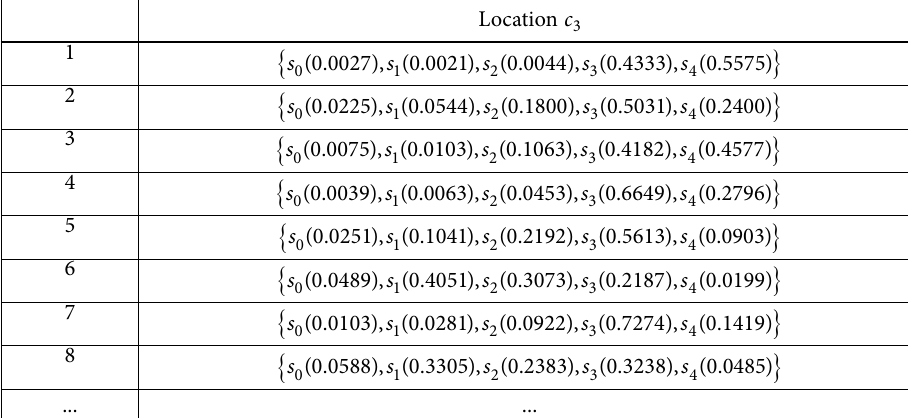
Table 3. Partial data under the attribute “location”